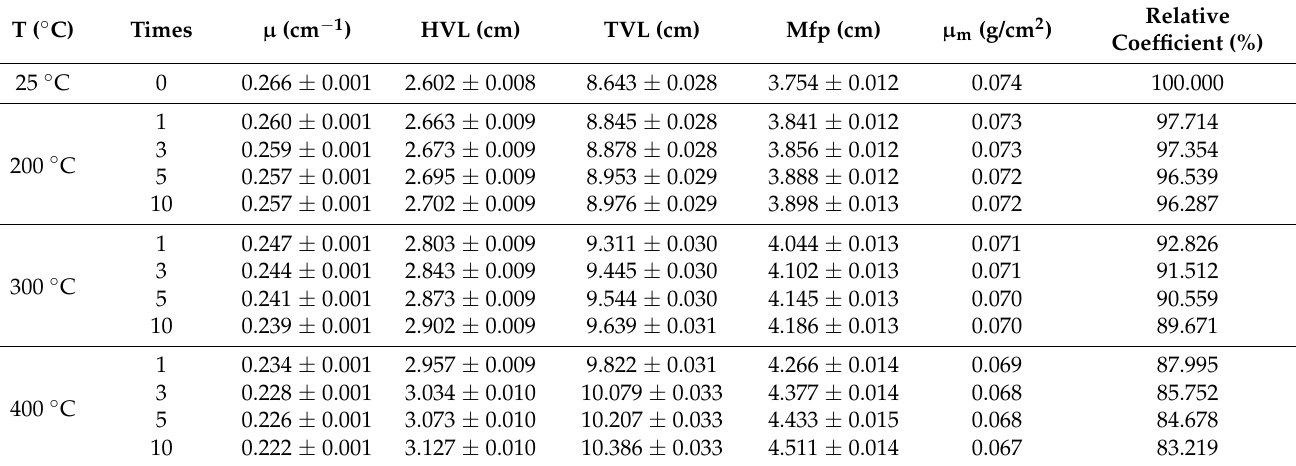
Figure 11. Relationship between ln(I/I 0 ) and concrete thickness at 400 °C. Table 5. Gamma-ray shielding experimental results of magnetite samples under repeated heating at high